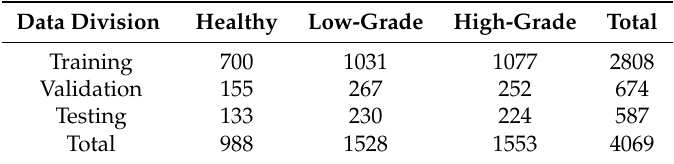
Table 4. Data division in the